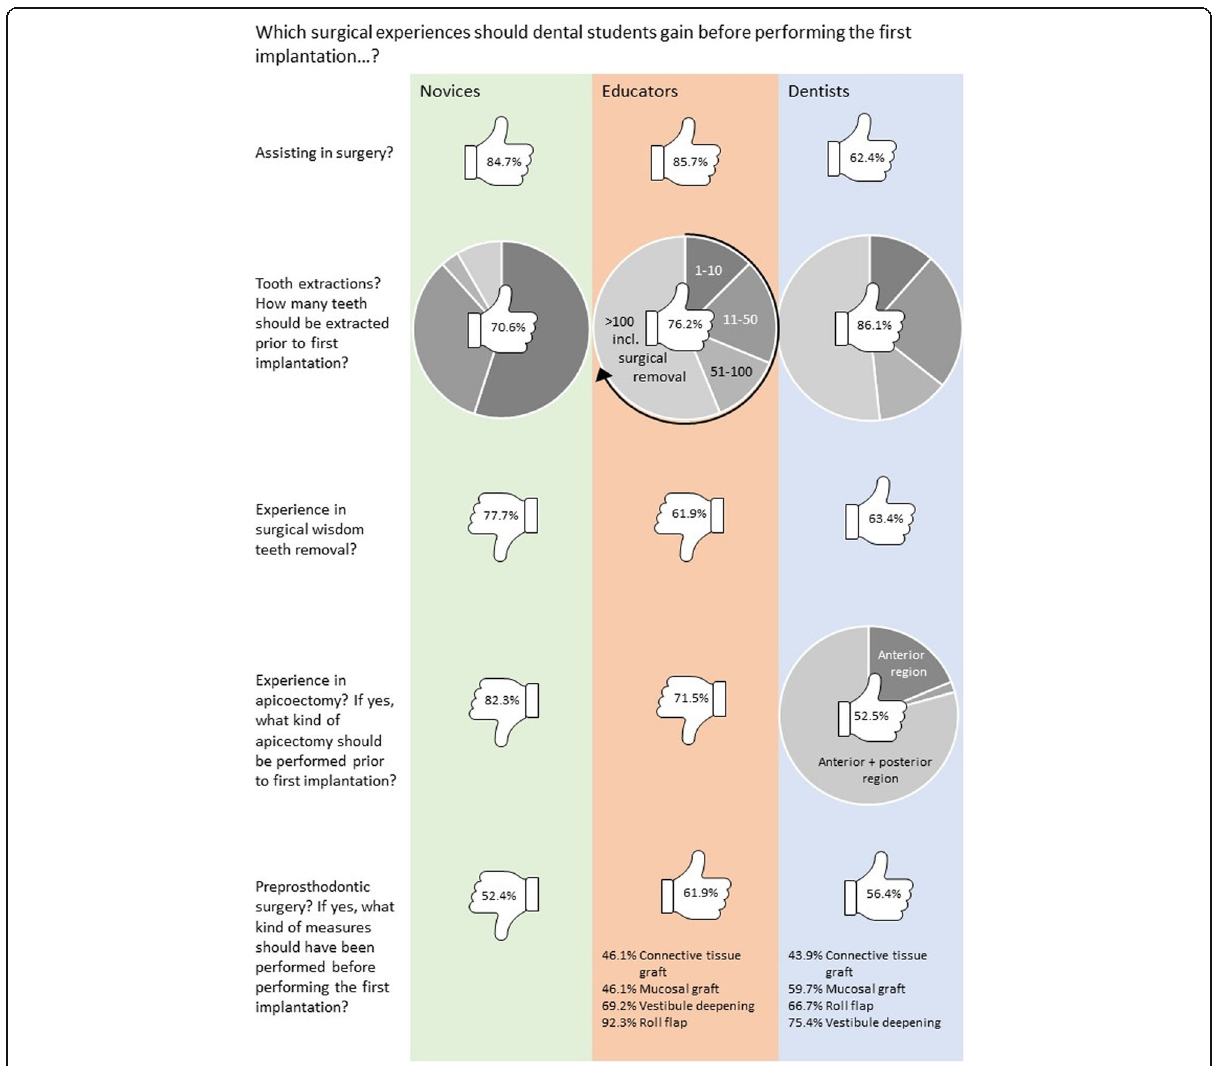
Fig. 4 Answers to questions about surgical prerequisite experiences before performing the first implantation. The percentages within the thumbs indicate acceptance (thumb up) or rejection (thumb down) within the three groups (i.e., novices, educators, and